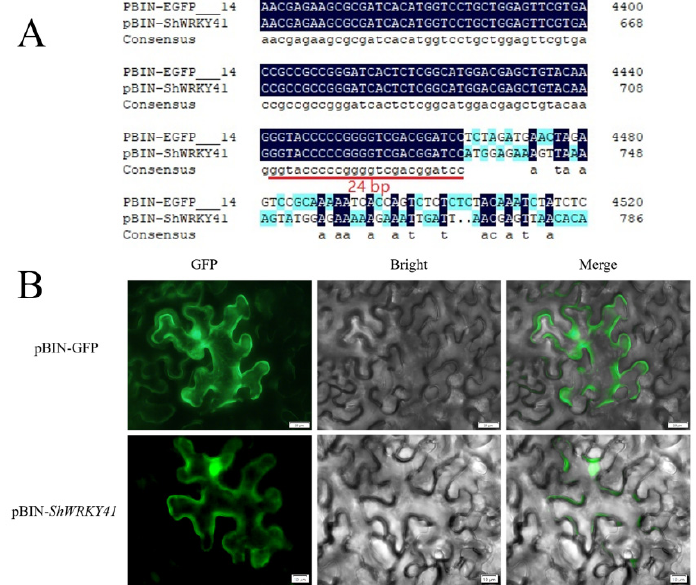
Figure 6. Sh WRKY41 located in plasma membrane and nucleus. ( A ) The sequence analysis of pBIN- ShWRKY41 vector by Sanger sequencing. The 24 bp gap means that the GFP coding sequence and CDS of ShWRKY41 did not exist frameshift mutation. ( B ) Images were collected by confocal microscopy at 24 h post pBIN- ShWRKY41 inoculation. Green fluorescent protein (GFP) signal was visualized by confocal microscopy.